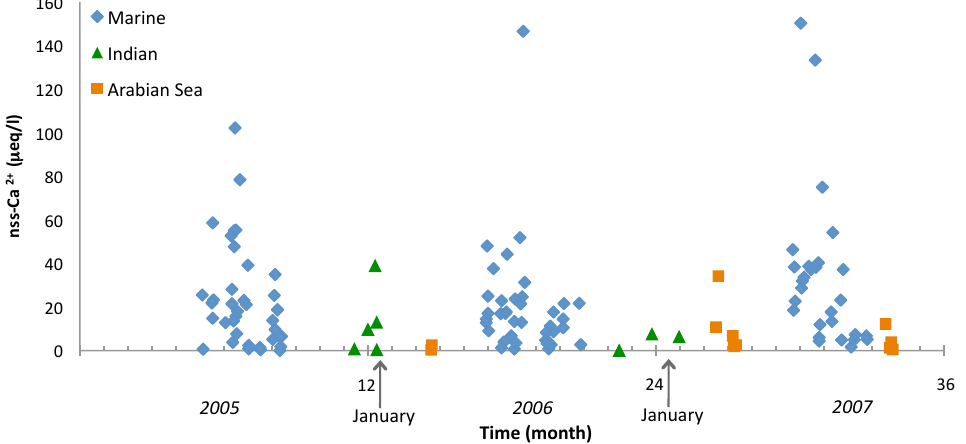
Fig. 4. Concentration of nss-Ca 2 + (in µeql − 1 ) as a function of time in the three trajectory groups Marine, Arabian Sea and Indian, defined in Sect. 2.4).